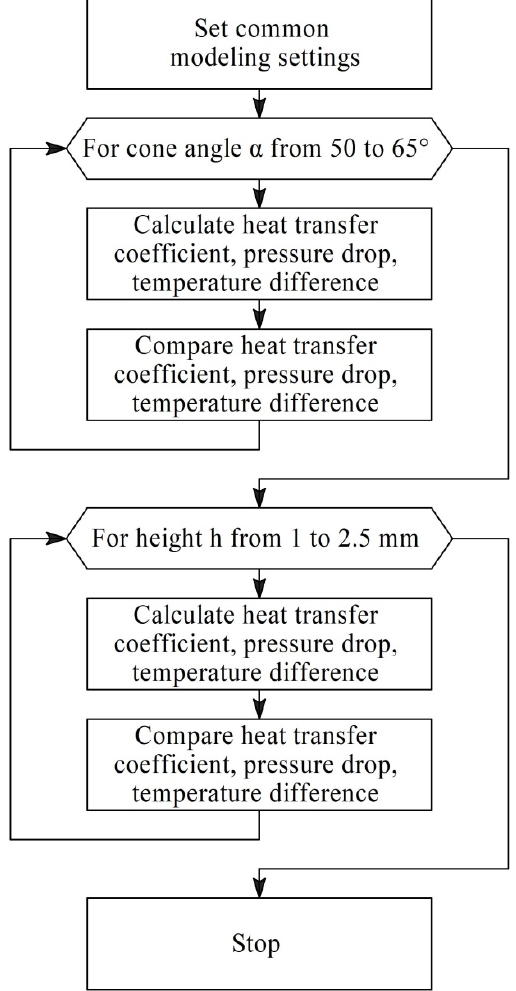
Figure 13. Algorithm of the optimization.